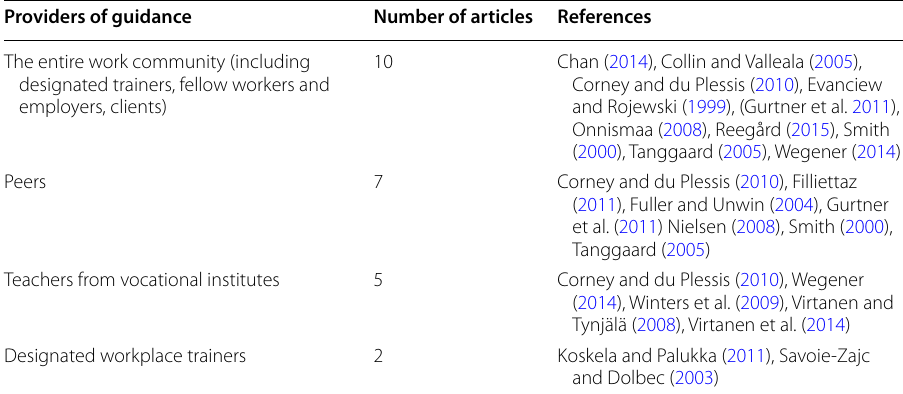
Table 3 Providers of guidance at work Providers of guidance Number of articles